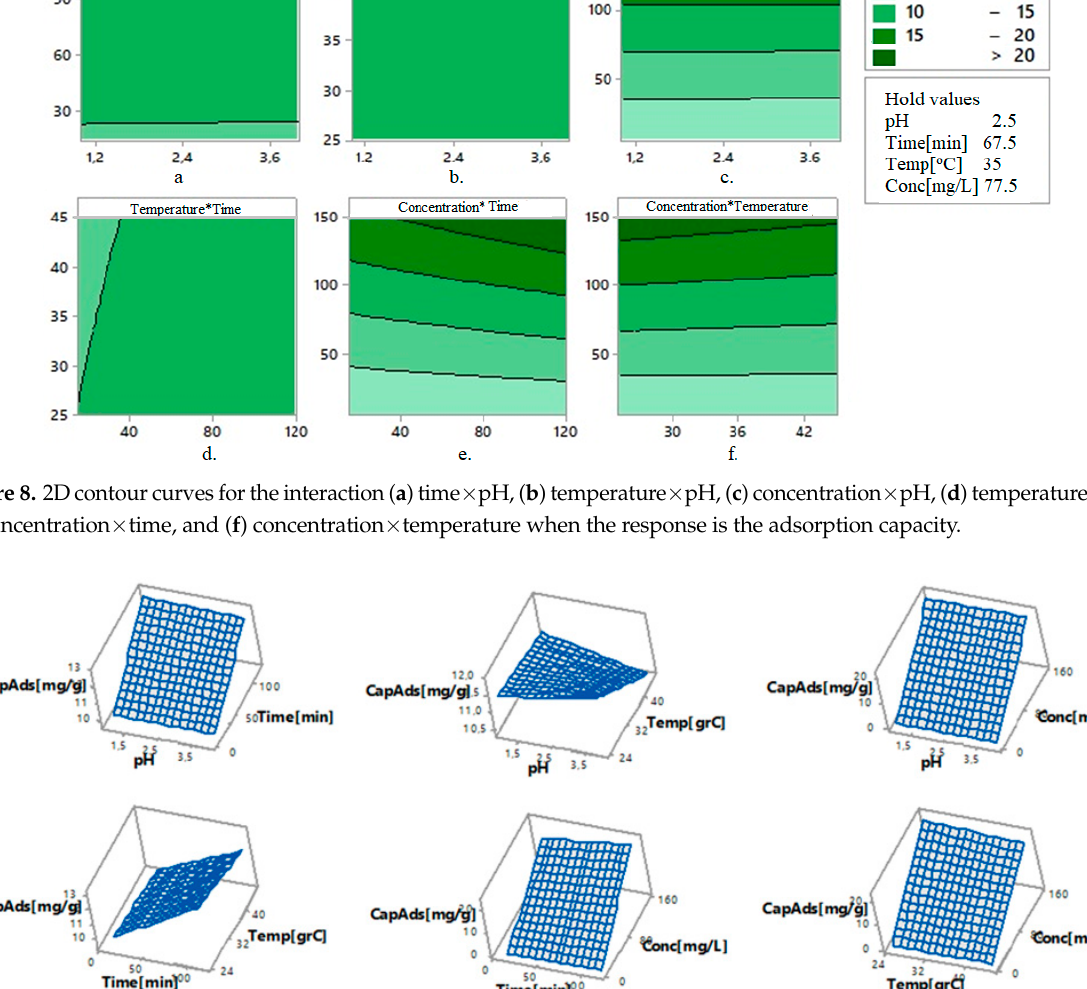
Figure 9. 3D contour curves for the interactions time×pH, temperature×pH, concentration×pH, temperature×time, concentration×time, and concentration×temperature when the response is the adsorption capacity (CapAds (mg/g)).